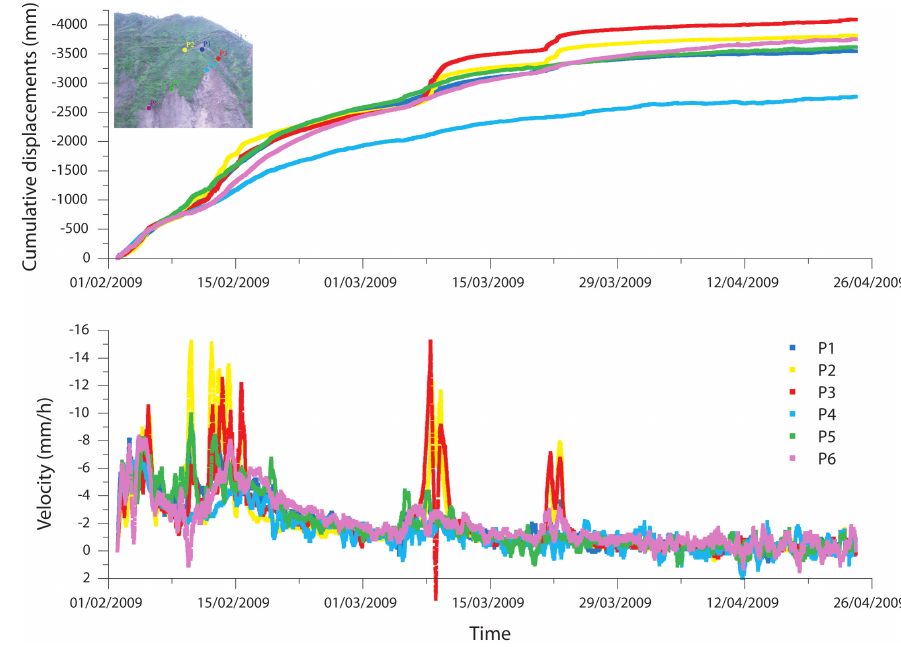
Fig. 8. Cumulative displacement versus time diagram (on the top) and velocity versus time diagram (on the botton).